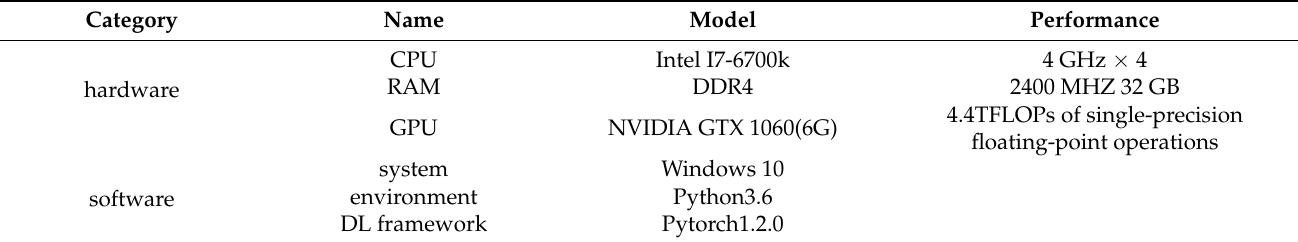
Table 4. Experiment running environment information.